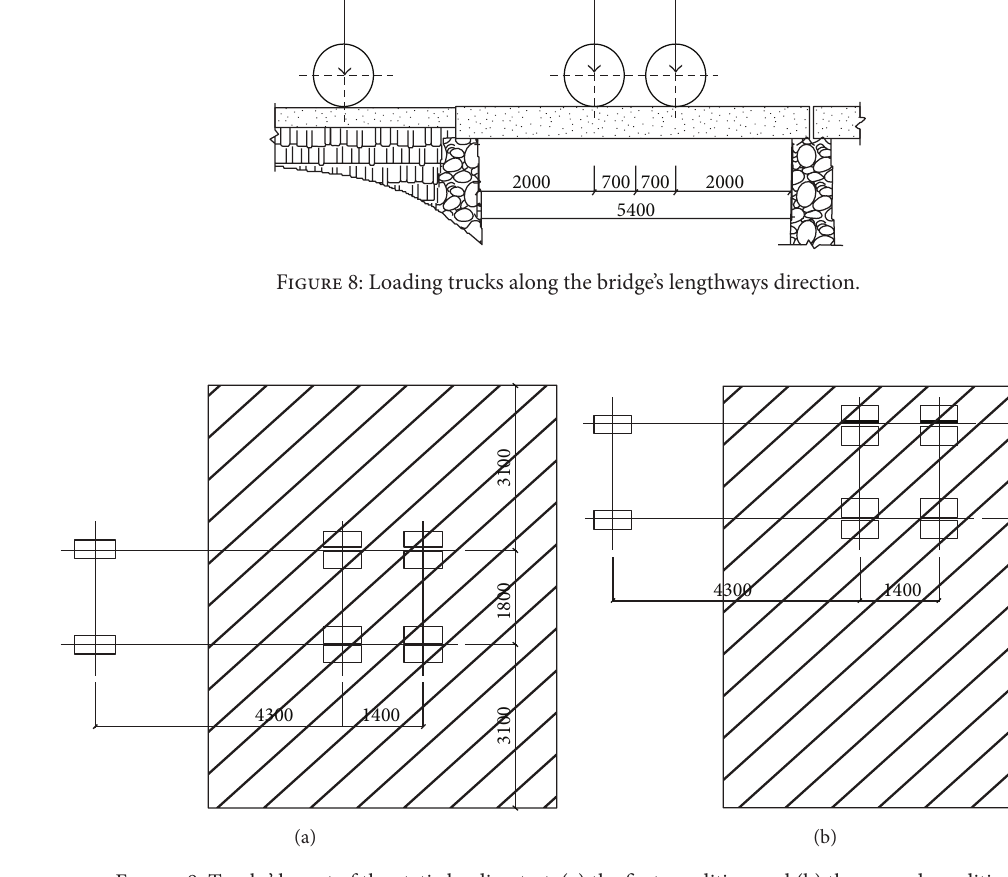
Figure 9: Trucks’ layout of the static loading test: (a) the first condition and (b) the second condition.